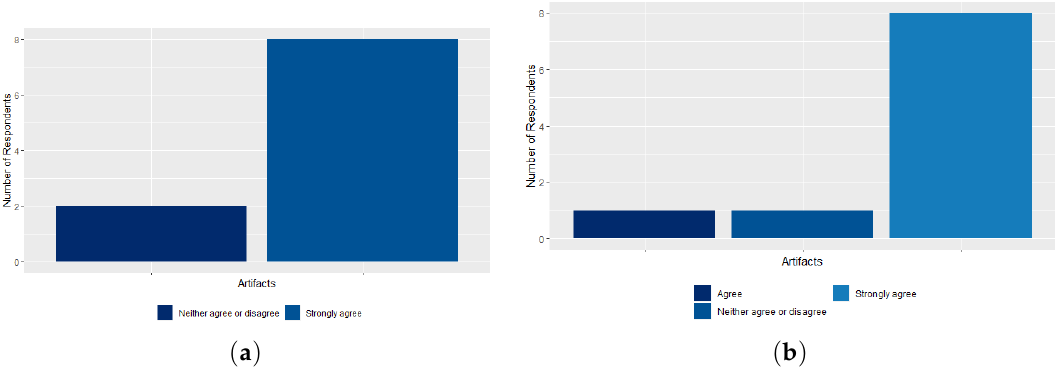
Figure 20. ( a ) The perception of CGTI workers in relation to the institution of a working group to implement ICT processes at CADE; ( b ) the perception of CGTI workers in relation to whether the ICT processes presented will contribute to the improvement of ICT Governance processes at CADE.